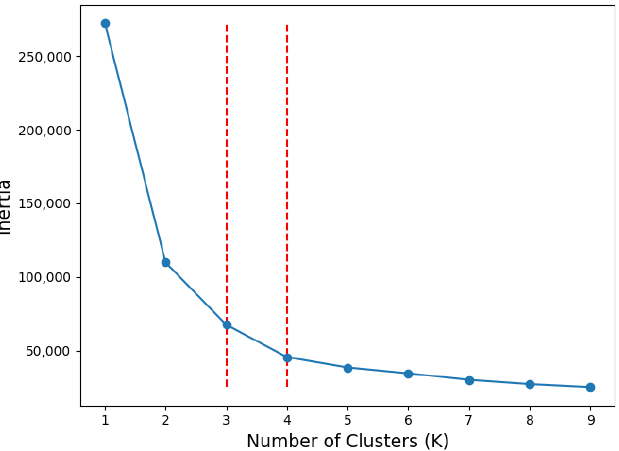
Figure 7. Inertia values at different K values; the optimal K values are marked with dashed lines.